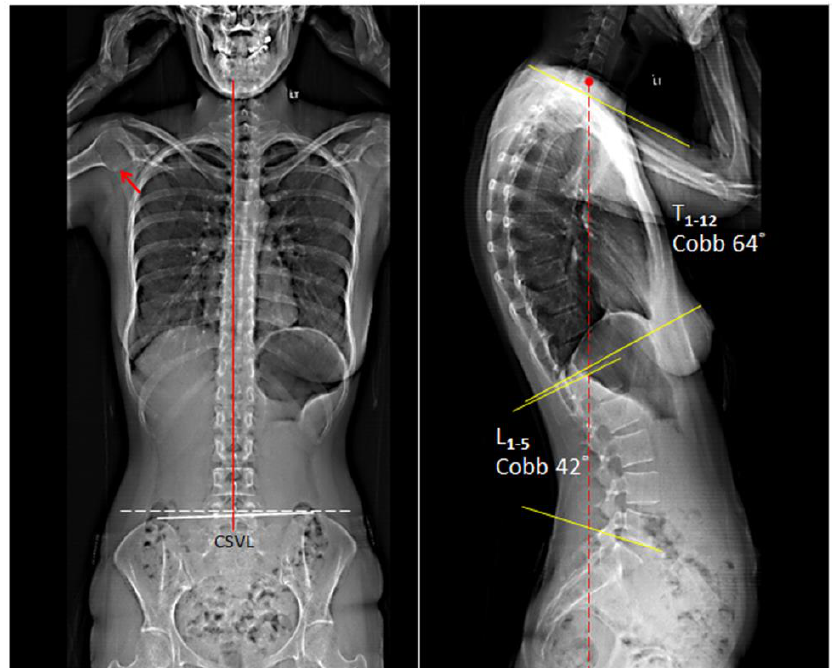
Figure 1. EOS ® radiographs demonstrating degenerative spondylosis of the lower cervical spine with osteophytes at posterior C5 and C6, C7/T1 disc-space narrowing, straightened cervical lordosis and thoracic hyperkyphosis, and cystic change of the right humeral head (red arrow). In general, the average angle of thoracic kyphosis and lumbar lordosis is 43.55° ± 6.44 and 32.42° ± 6.29, respectively. CSVL: central sacral vertical line (red line).